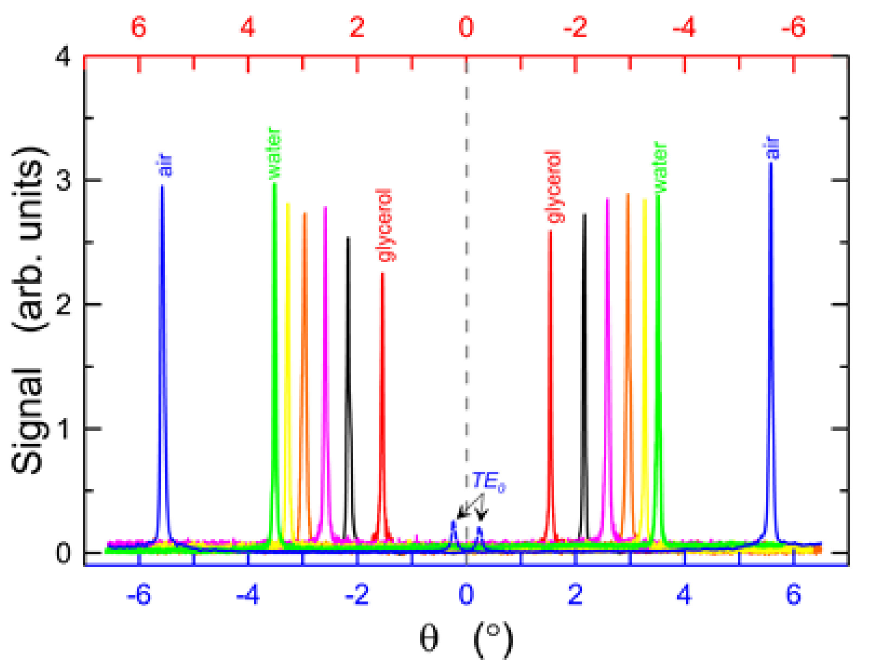
Figure 13. Modal spectra of the investigated sensing structure excited with the use of grating coupler for different refractive indices of the cover. The remaining parameters have the following values: